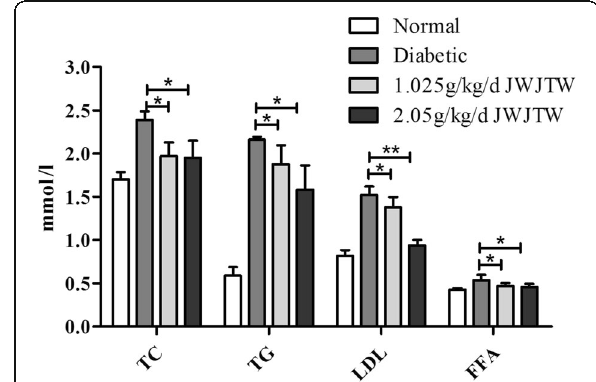
Fig. 4 Effects of JWJTW on lipid metabolic parameters of diabetic rats. TC: total cholesterol, TG: triglyceride, LDL: low-density lipoprotein, FFA: free fatty acids. * p <0.05, ** p< 0.01 ( n